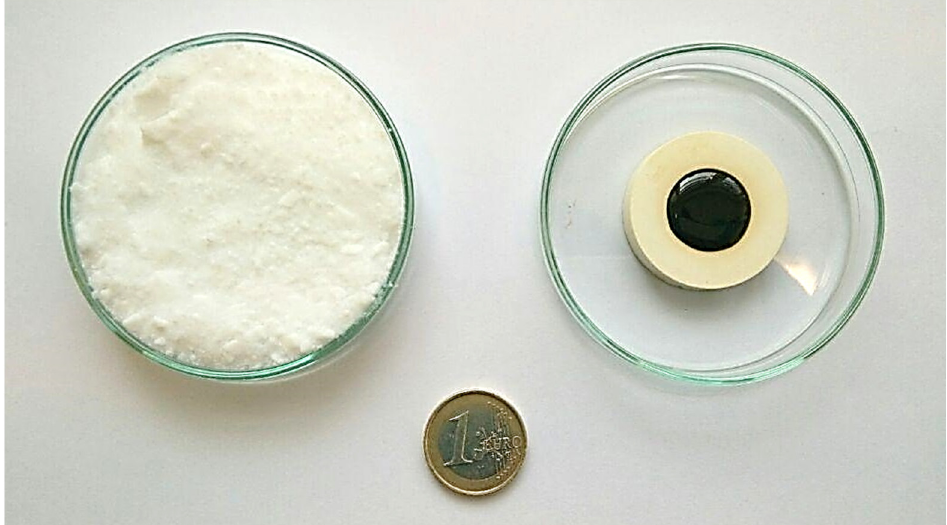
Figure 1. ( left ) Fumed silica nanoparticles and ( right ) the bitumen sample.